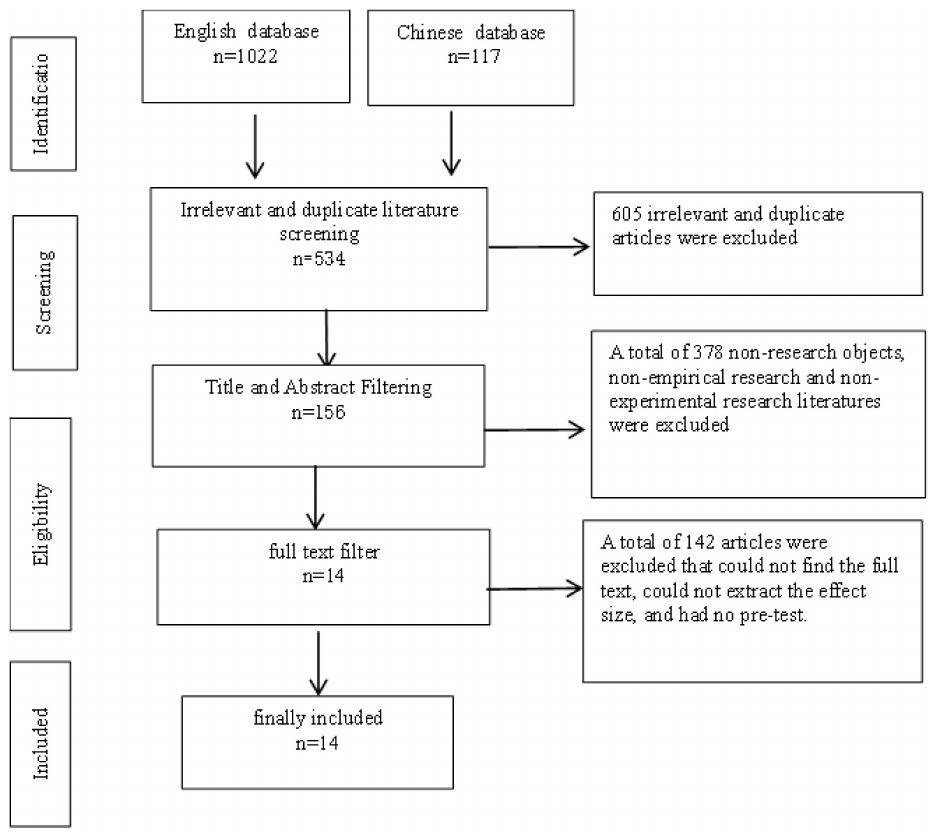
Figure 1. The flow chart of literature